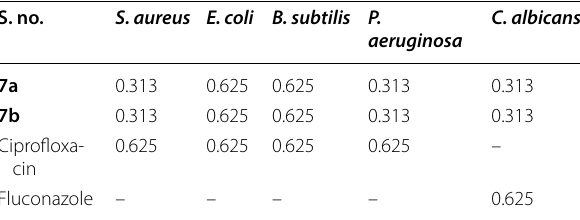
Minimum inhibitory concentration (MIC; µg/ml)